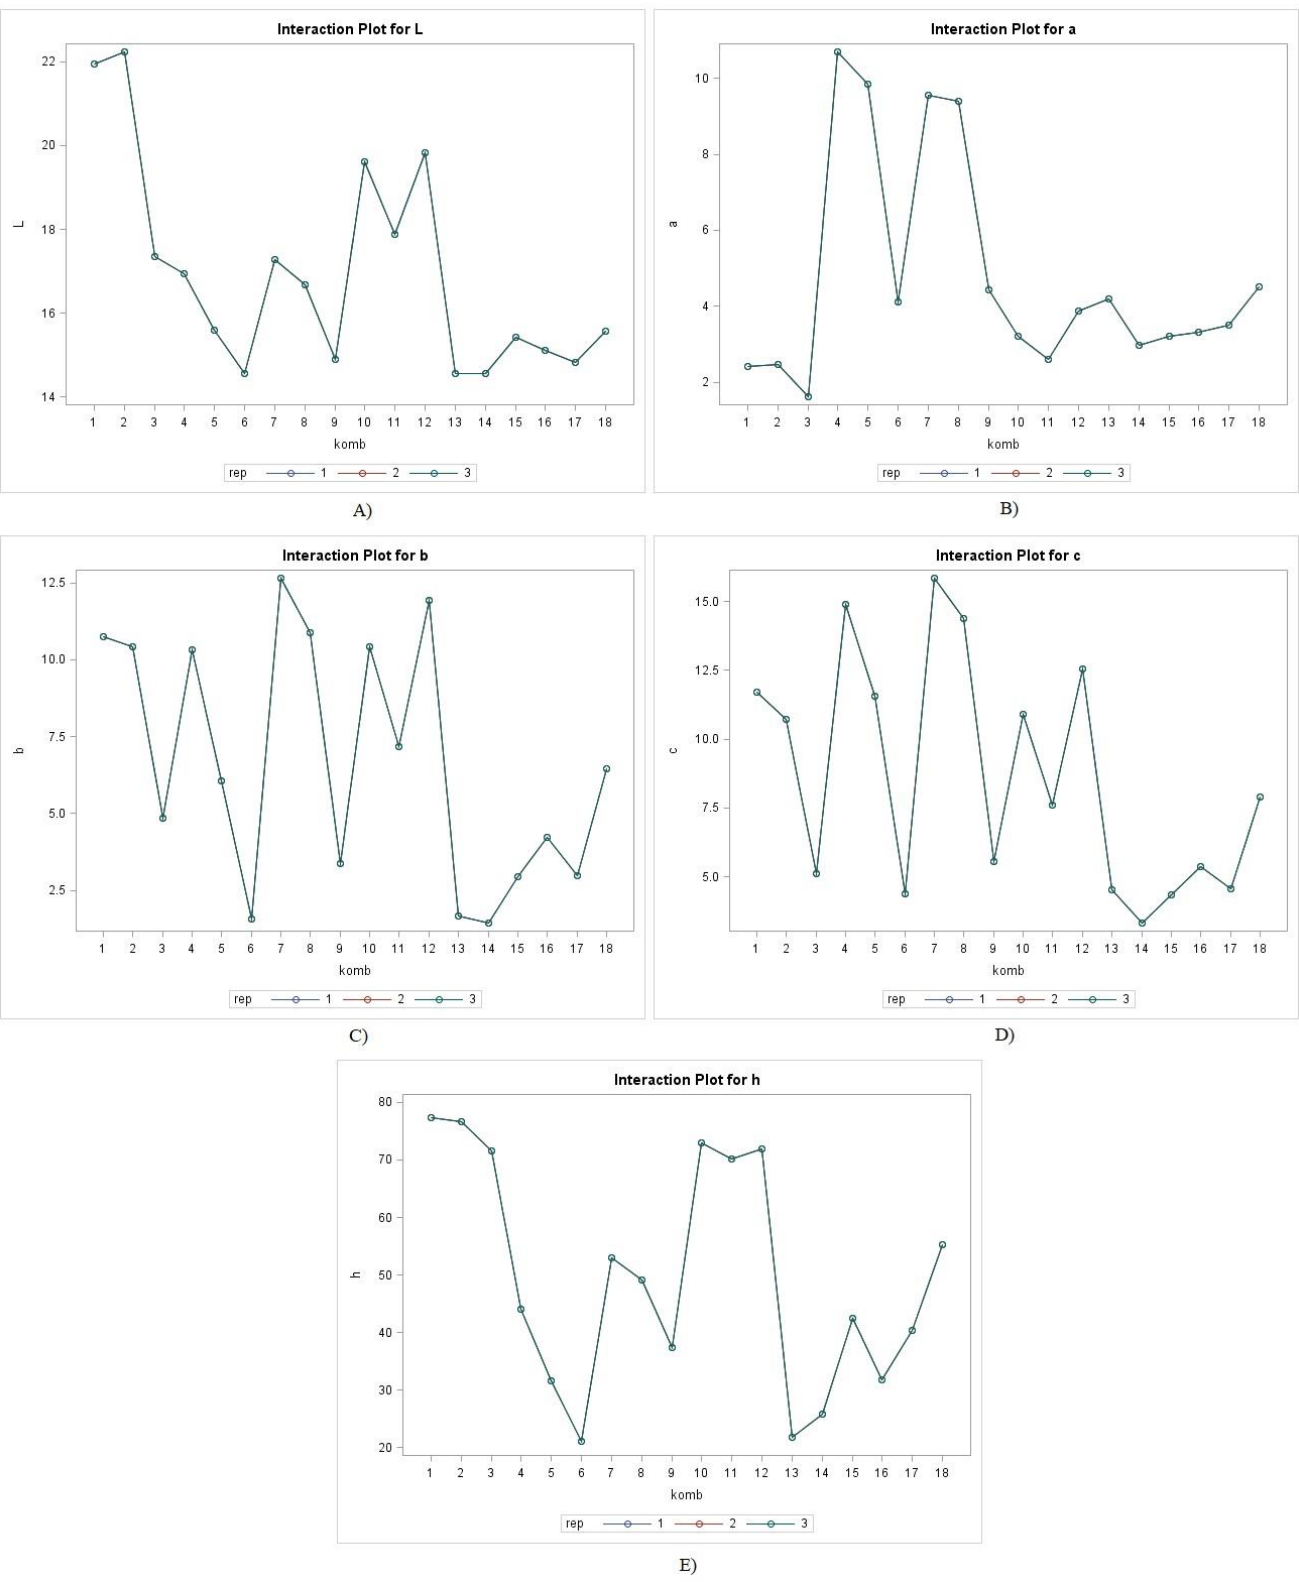
Figure 2. Chromaticity parameters: ( A ) L; ( B ) a; ( C ) b; ( D ) c; ( E ) h of garlic (classic 1–3; UAE 10–12), ginger (classic 4–6; UAE 13–15) and turmeric (classic 7–9; UAE 16–18) extracts.